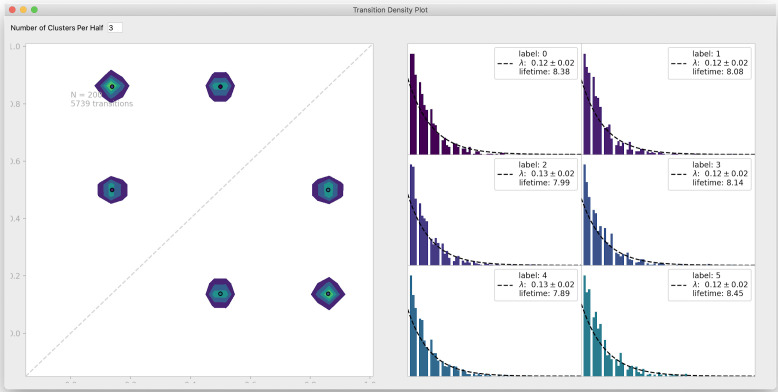
Transition density window.To visualize transitions between FRET states, DeepFRET includes a window to fit exponential lifetime distributions of clusters in a transition density plot. The transition density interface also allows the user to test a different number of clusters for the transition density window. Data is simulated from DeepFRET’s trace generator with three states with means 0.15, 0.5, and 0.85, as in Figure 2—figure supplement 2b.